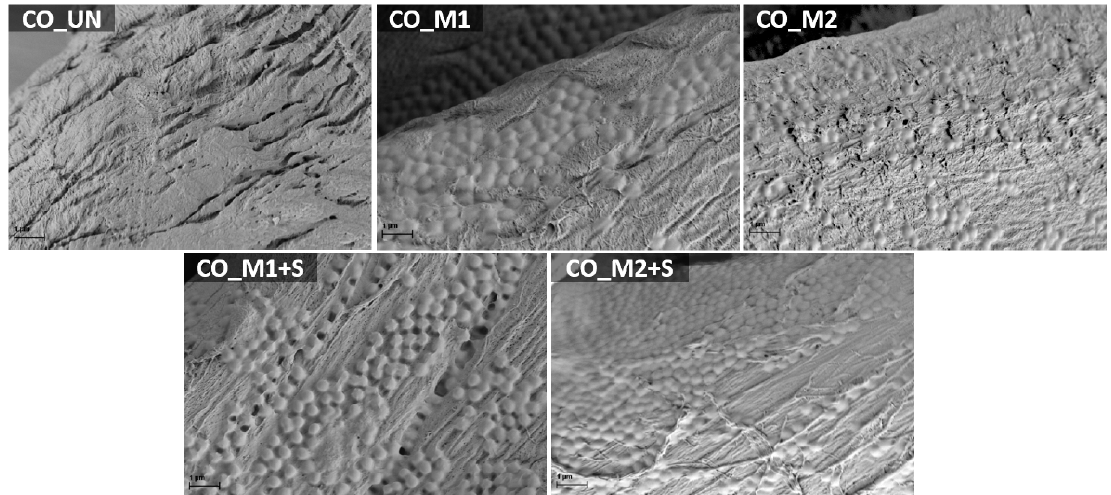
Figure 5. Scanning electron microscopy images of the untreated sample (CO_UN) and the samples finished with bare and functionalized PNCS/CD M1 and M2 hydrogels (CO_M1, CO_M2 and CO_M1+S, CO_M2+S) obtained at the magnification of 25,000 times.